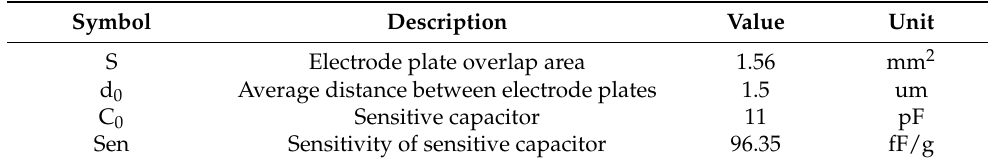
Table 1. The characteristic parameters of the experimental sample.